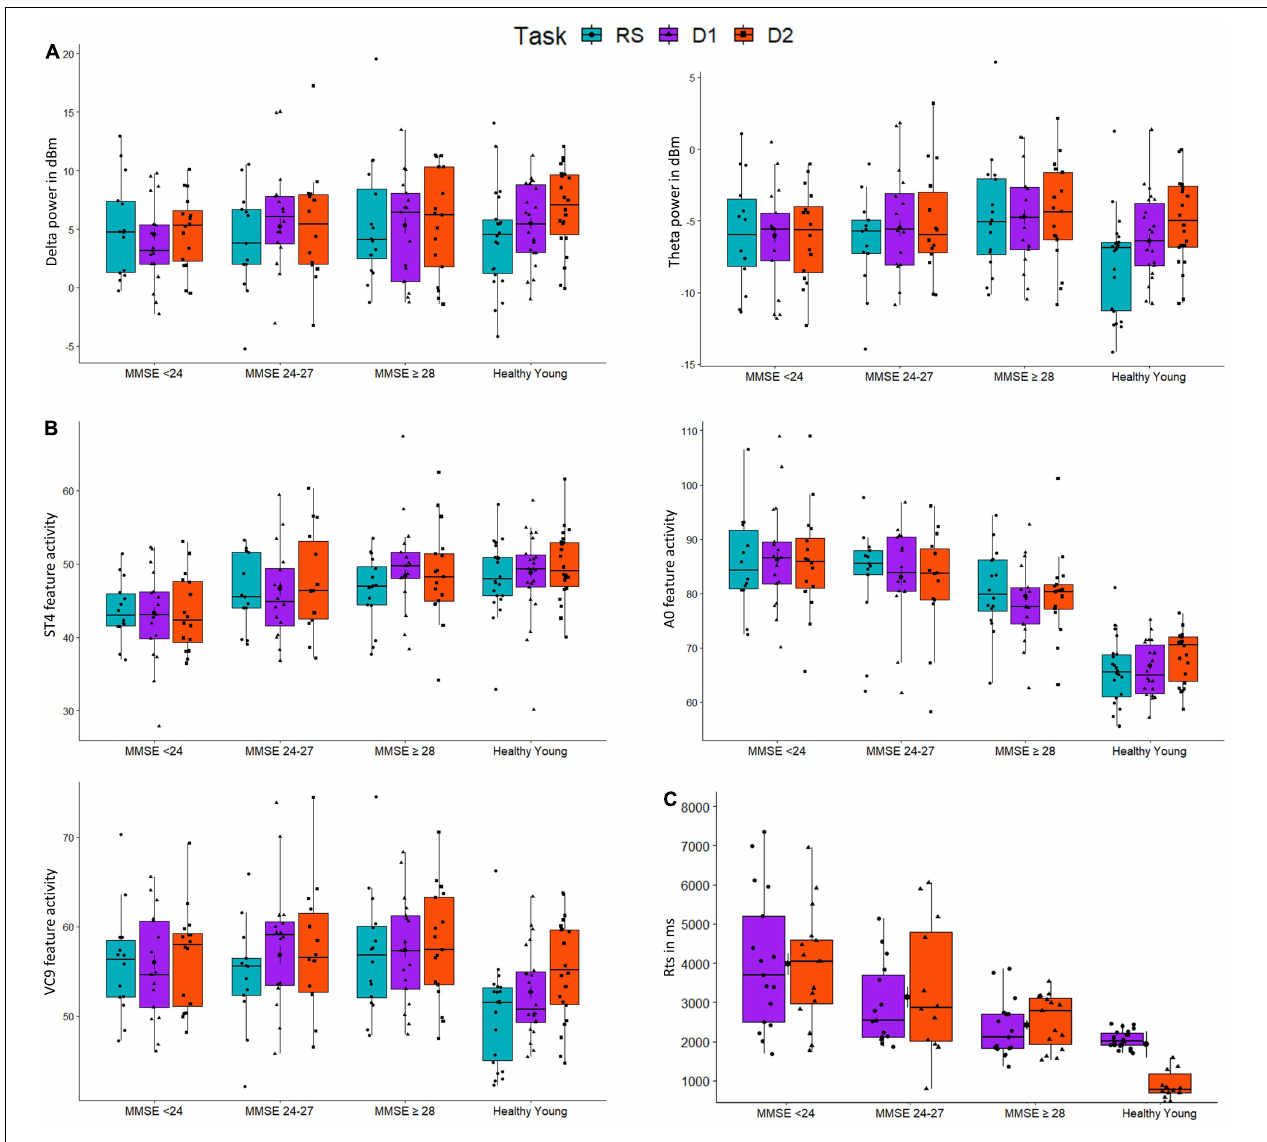
FIGURE 5 | The distributions of groups (MMSE < 24, MMSE 24-27, MMSE ≥ 28, and healthy young) for activity of EEG features (A) Delta and Theta; (B) A0, ST4 and VC9; and (C) reaction times (RTs), as a function of task: resting-state (blue), detection level 1 (purple), and detection level 2